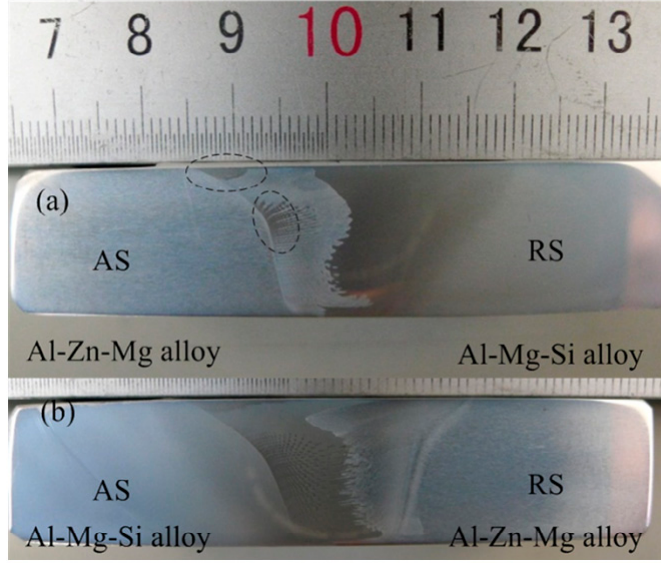
Figure 4. Cross sectional photos of the joints: ( a ) AS: Al-Zn-Mg and ( b ) AS: Al-Mg-Si, reproduced from [38], with permission from Elsevier, 2016.